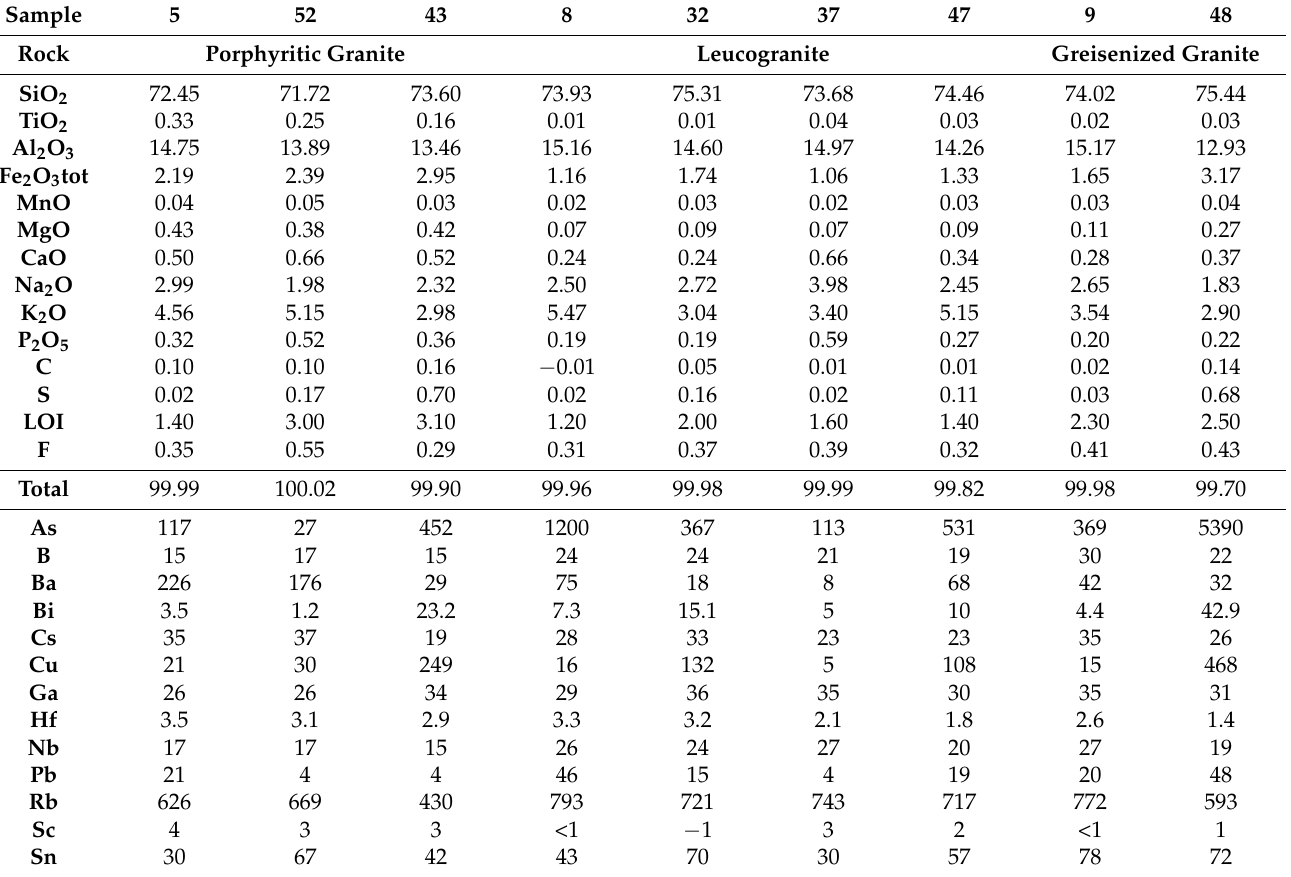
Table 2. Bulk-rock chemical composition of the studied granites and greisens (wt.%, traces in